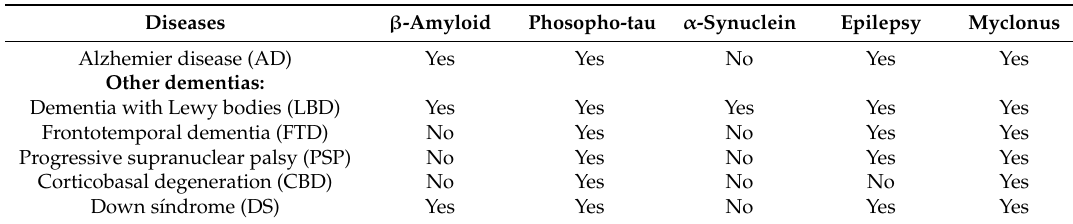
Table 1. Neuropathological hallmarks of microtubule associated protein tau gene (MAPT)-related diseases with myoclonus and/or